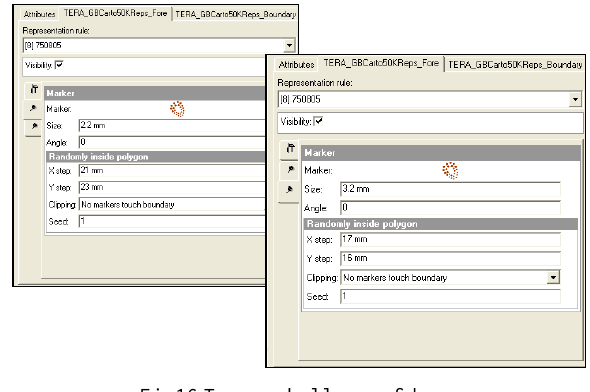
Fig.16 Two symbol layers of